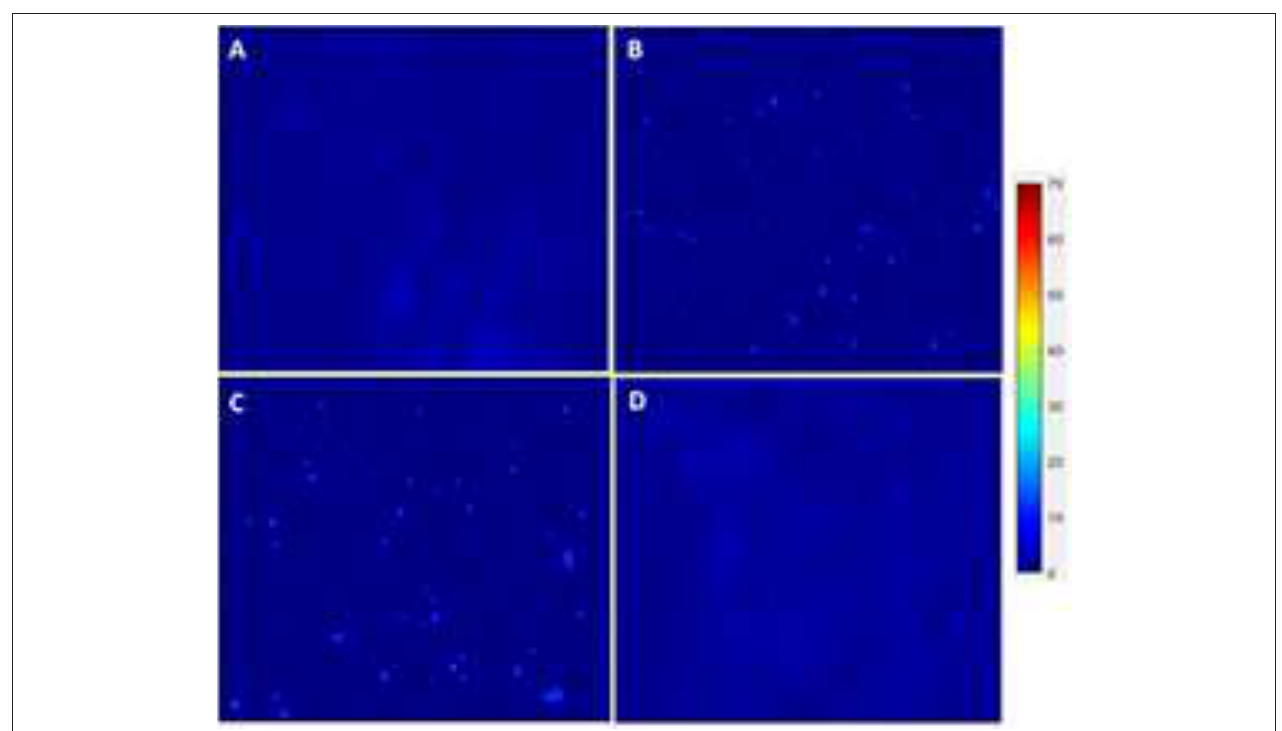
FIGURE 13 | hBM-MSCs differentiation toward CD31 heat map. PGA-PLLA scaffolds seeded with hBM-MSCs from previous experiments (5) compared to our experiments demonstrating heat maps of CD31 in averaged (A) static, (B) PHV, (C) flex-flow, and (D) oscillatory flow groups. Resolution of 1,024 × 690